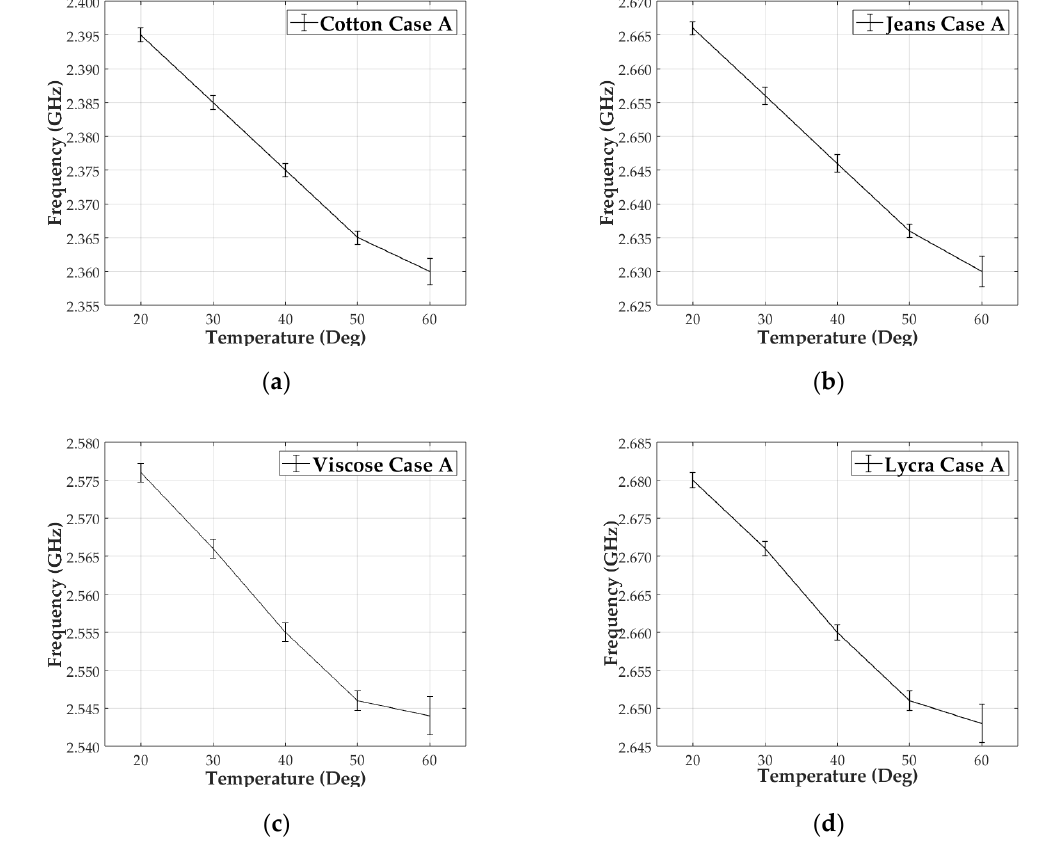
Figure 9. Measured frequency vs temperature representation. Case A at 2.45 GHz: 20–60 ◦ C / 10 ◦ C steps for: ( a ) Cotton; ( b ) Jeans; ( c ) Viscose and ( d ) Lycra.